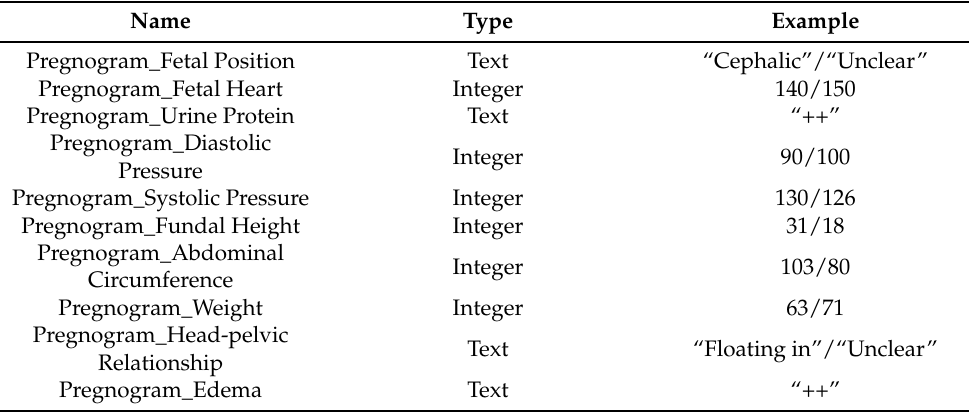
Figure 1. Distribution of physical examination times during 0-70 weeks of pregnancy. The data mainly include 4 parts: pregnogram examination data, routine urine data, routine blood data and biochemical D data. The pregnogram examination data contain the results of 10 kinds of pregnancy examinations, including weight, fundal height, diastolic pressure, fetal position, etc. Table 1 lists the name and examples of each indicator. Routine blood data, routine urine data and biochemical D data contain the results of 141 examination indicators, such as platelet count, white blood cell and hemoglobin. Table 1 lists each category and indicator of the 3 examinations. Urine protein (++) means that the urine protein is 1.0–2.0g/L, which is higher than the normal range.Edema ++ indicates a severity level of 2 for edema. All examination indicator can be viewed in Table A1 in Appendix A. Table 1. Indicators of pregnogram